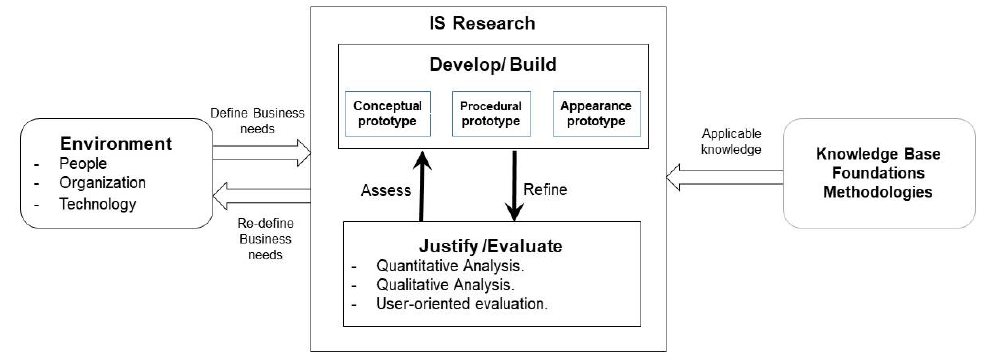
Figure 2. Methodology for developing the ICT-based application for cargo